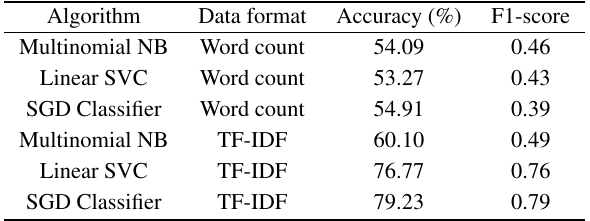
Fig. 1 System architecture.